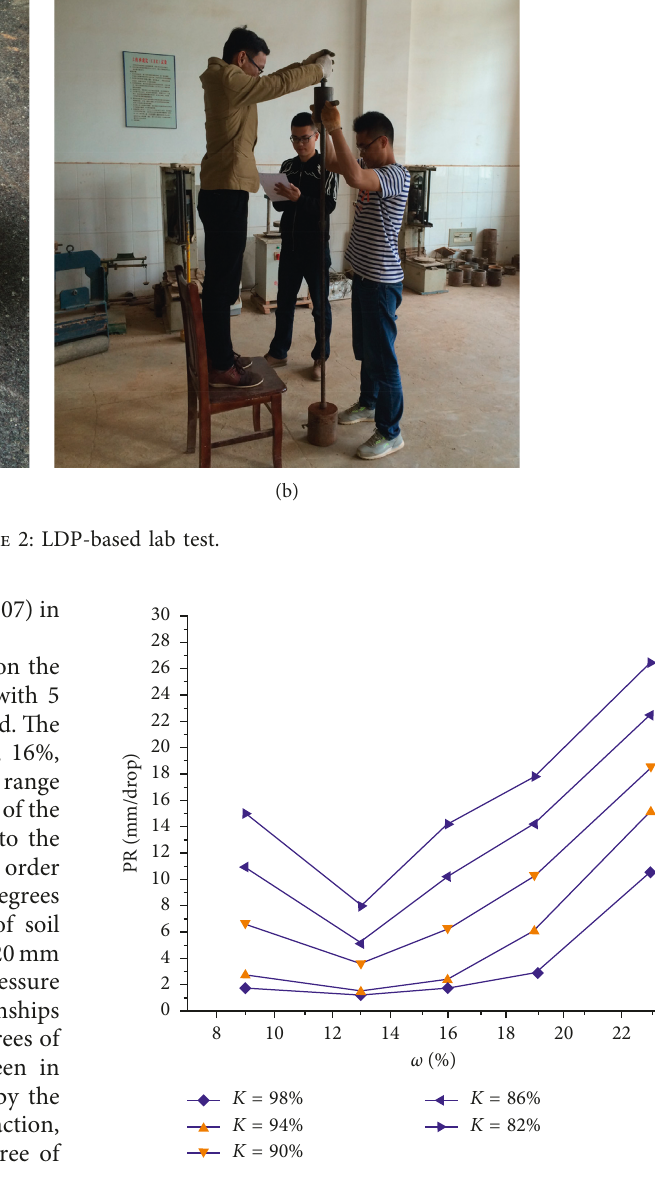
Figure 3: PR- ω under different compaction